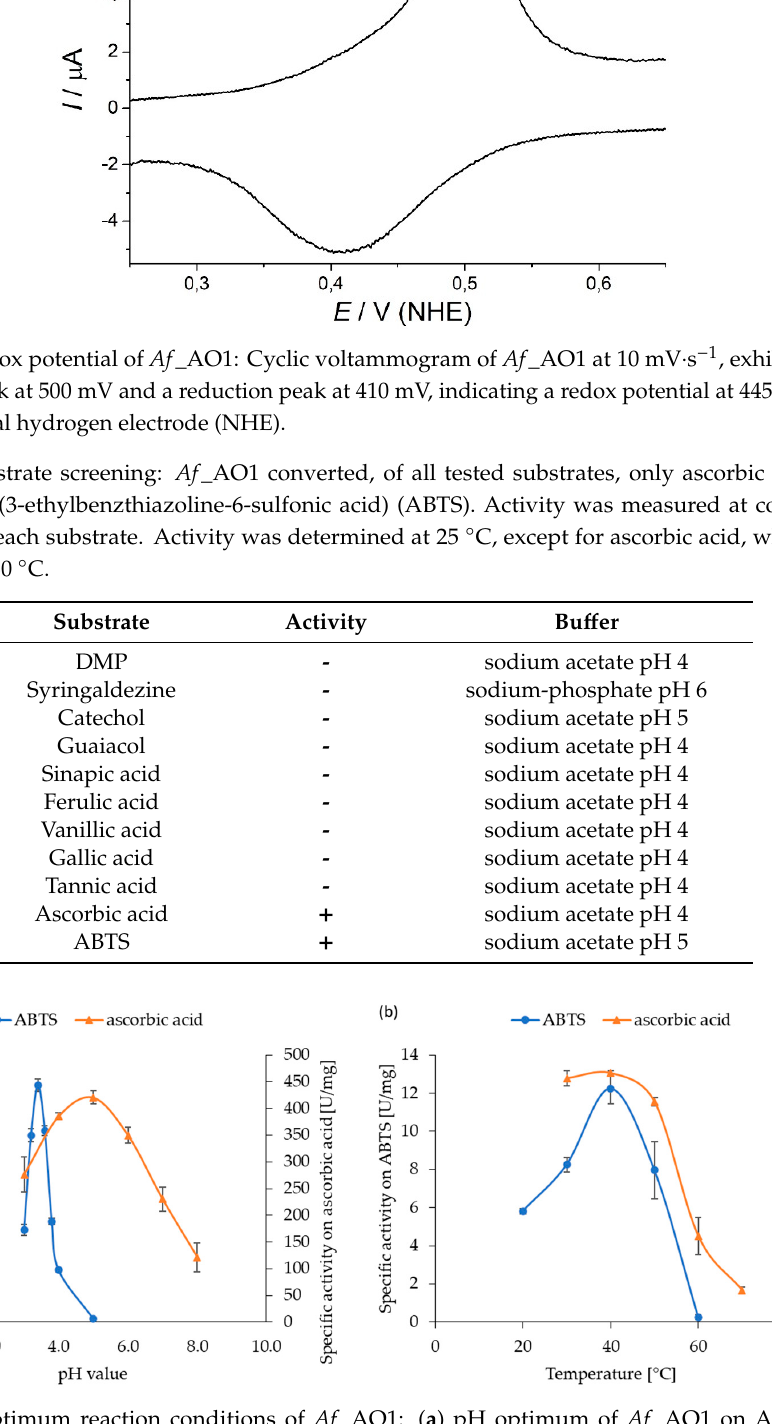
Figure 3. Optimum reaction conditions of Af _AO1: ( a ) pH optimum of Af _AO1 on ABTS was determined at 25 °C and that on ascorbic acid at 30 °C. ( b ) Temperature optimum of Af _AO1 on ABTS and ascorbic acid was measured at the respective optimal pH values of pH 3.4 and pH 5, respectively. Experiments were conducted in triplicates. The error bars depict standard deviation.